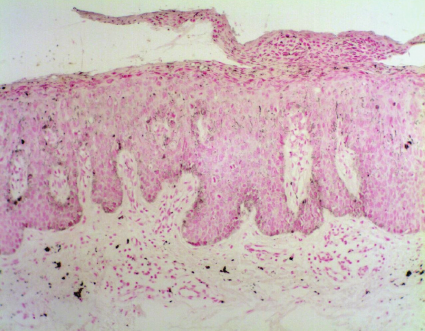
Figure 11: Case 1. Fontana Masson stain highlights pigment in corneocytes, dendritic melanocytes, dermal melanophages, and scarcely in